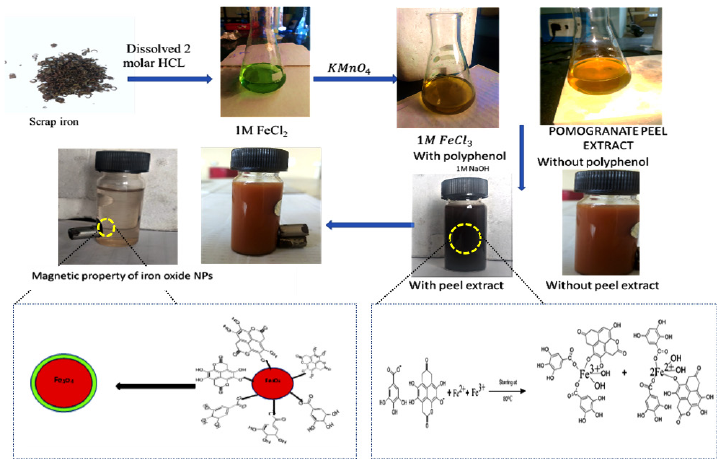
Figure 6. Representation of the formation mechanism of magnetite NPs by means of PoP’s peel extract and scrap iron precursors along with the synthesis of magnetite iron oxide NPs by using scrap iron in PoP’s